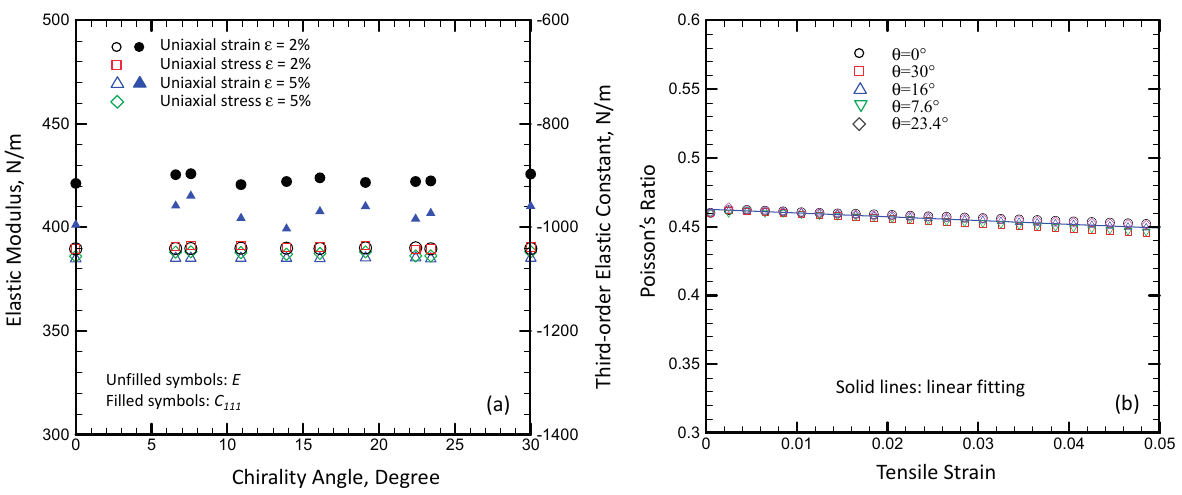
Figure 2. Elastic properties of monolayer graphene determined from in-plane tension along the different chirality angles: ( a ) the second-order elastic modulus E and the third-order elastic constant C ; and ( b ) Poisson’s ratio ν . 111